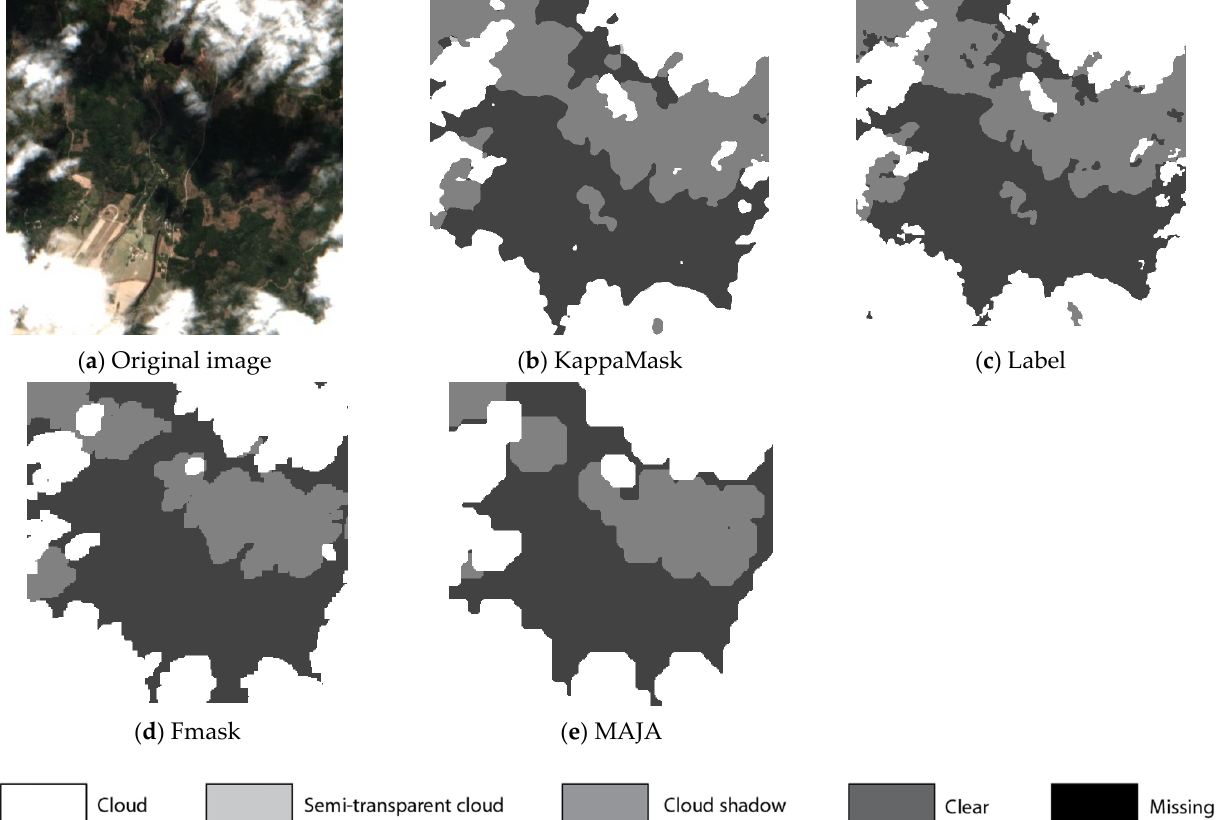
Figure 6. Comparison of L2A prediction output for a 512 × 512 pixels sub-tile in the test dataset. ( a ) Original Sentinel-2 L2A True-Color Image; ( b ) KappaMask classification map; ( c ) Segmentation mask prepared by a human labeller; ( d ) Fmask classification map; ( e ) MAJA classification map.